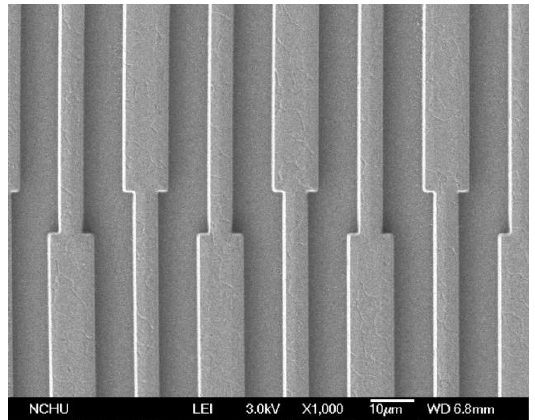
Figure 8. SEM image of the interdigitated electrodes.